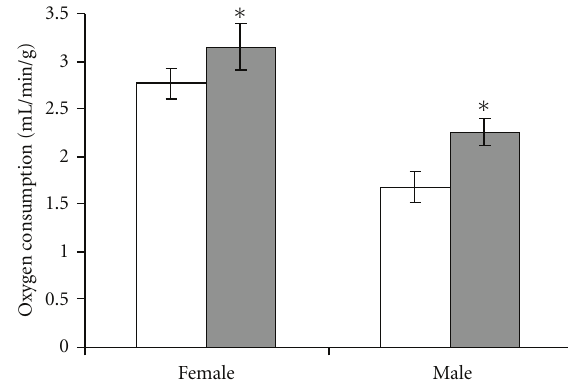
Figure 3: Neonatal SSRI exposure increases adult basal metabolic rates. Control (white bars) and SSRI-exposed mice (gray bars) were placed in a thermoneutral environment and oxygen consumption rates were measured during sleep (nadir in oxygen consumption). N = 27 control female (17 litters), 24 SSRI-exposed female (15 litters), 12 control male (9 litters), 13 SSRI-exposed male (10 litters); ∗ P = 0 . 033 versus control by